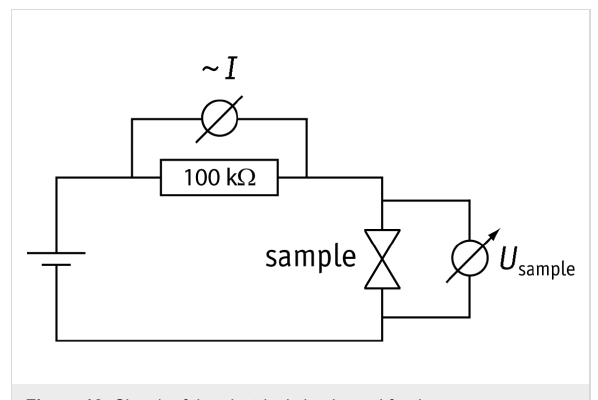
Figure 12: Sketch of the electrical circuit used for the measurements on the “dry” contacts.